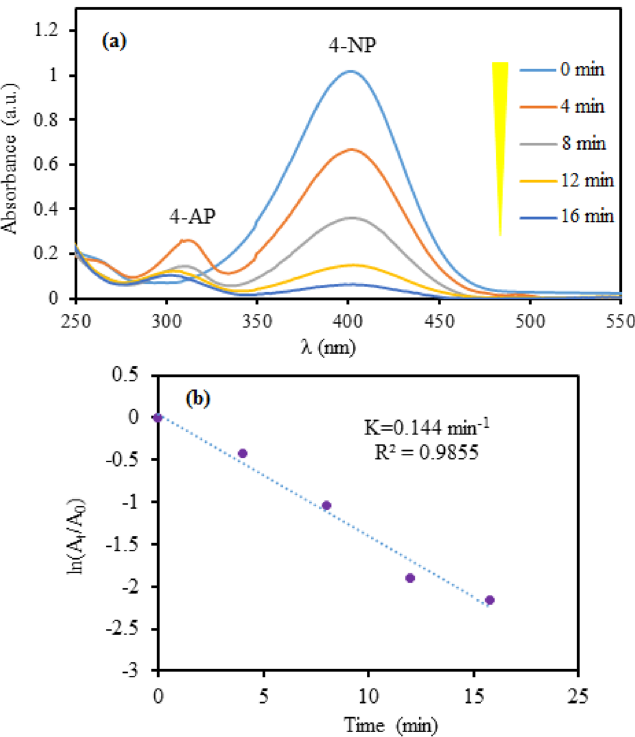
Figure 7. The UV–Vis spectroscopic study in the reduction of 4-NP to 4-AP over GO/Fe 3 O 4 @PDA/Au nanocatalyst.